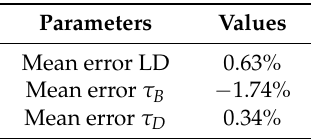
Table 6. Relative error between model and simulation.